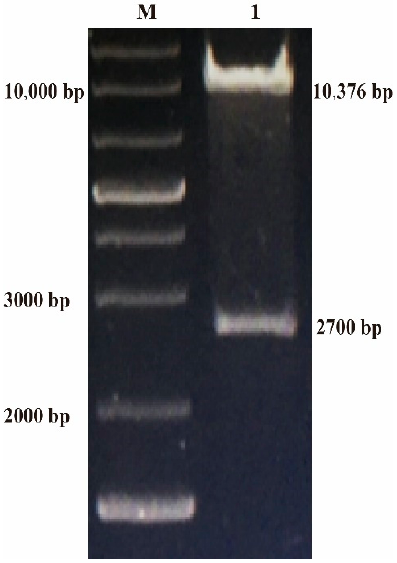
Figure 1. Identification of p12LS-gB by digestion with Bam H I and Sma I. After digestion with Bam HI and Xho I, the mutated synonymous gB gene of ILTV was inserted into plasmid, p12LS, which was digested with the same restriction enzyme, to form the transferring vector, p12LS-gB. The positive transferring vector plasmid p12LS-gB was identified by digestion with Bam HI and Xho I. M: 1 kb plus DNA ladder, 1: p12LS-gB digested with Bam H I and Sma I.